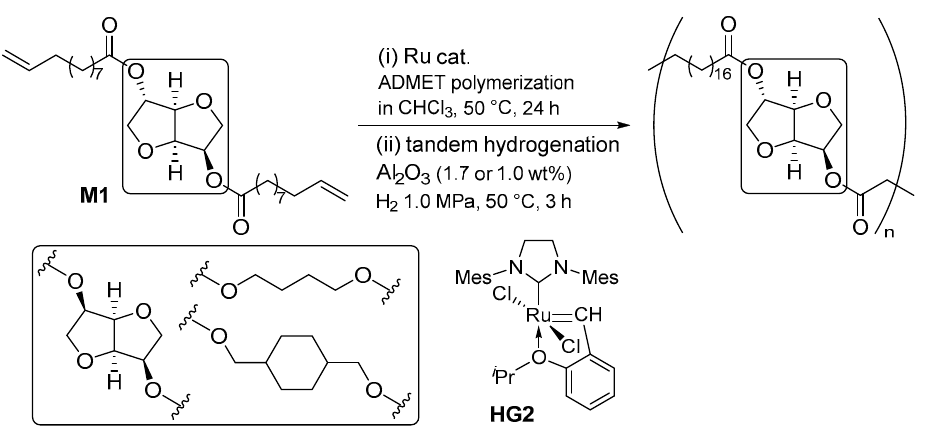
Scheme 1. One pot synthesis of bio ‐ based long chain aliphatic polyesters by tandem ADMET polymerization and hydrogenation [28].